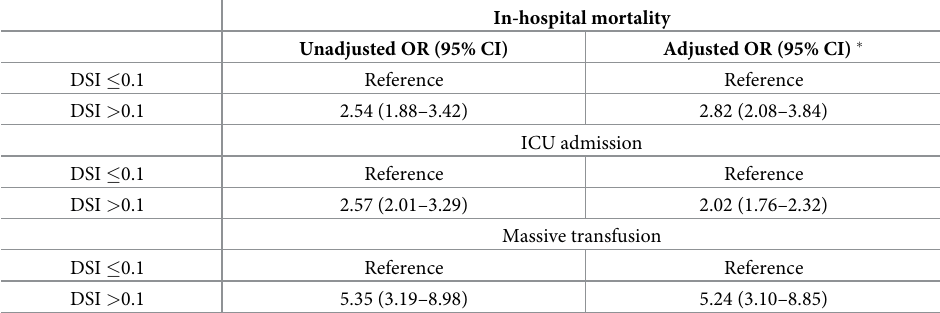
Table 3. Association between exposure groups and outcomes in multivariate logistic